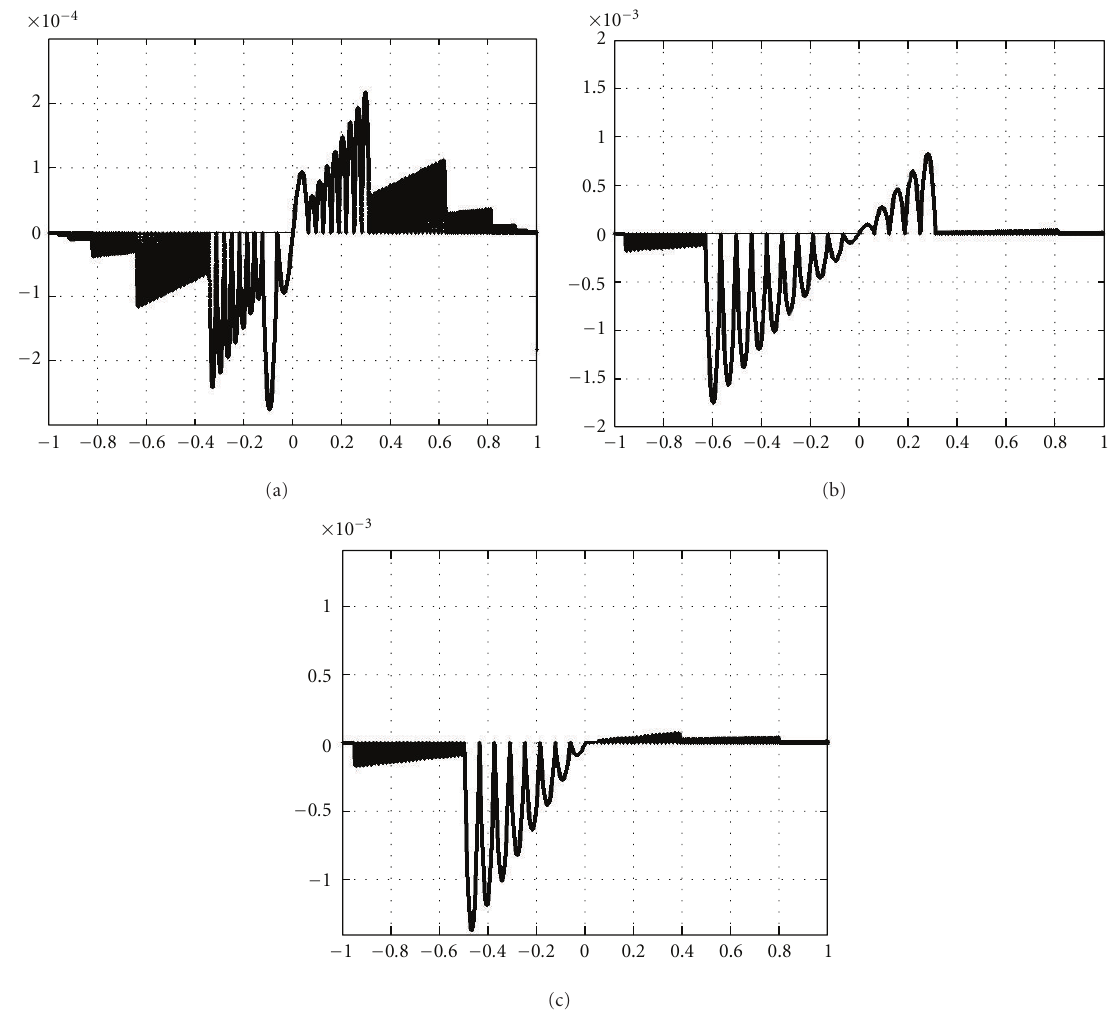
Figure 9: Approximation error obtained for the Cubic Function (18) using the sampling schemes α (a), β (b), and γ (c).